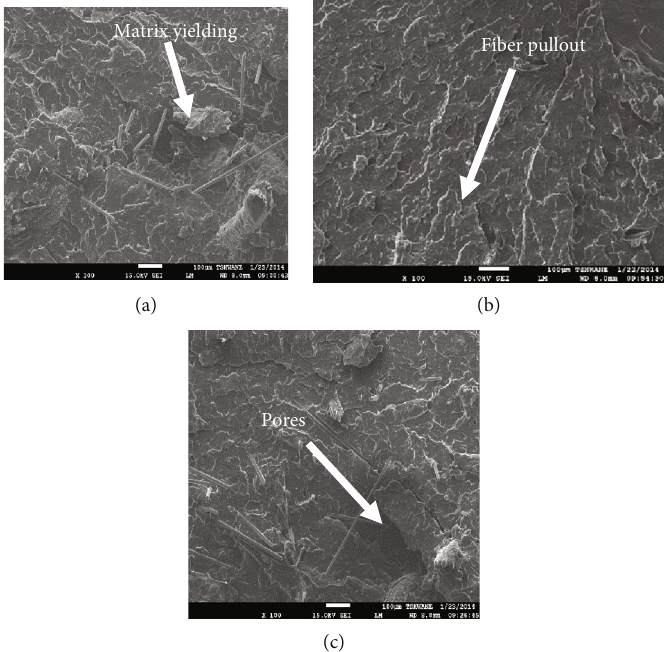
Figure 8: SEM images of NB1, NB2, and NB4 NaOH-treated